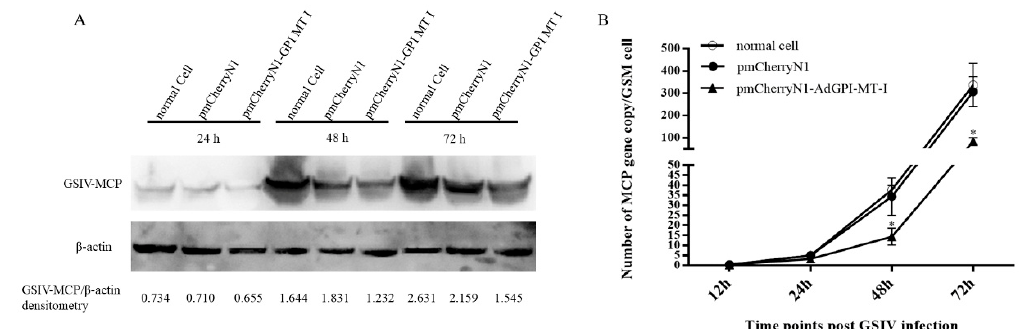
Figure 8. ( A ) Western blot analysis of MCP protein expression and grayscale quantitative analysis. Western blot was used to detect protein synthesis after GSIV infection at different times, and mouse anti-MCP monoclonal antibody and anti- β -actin monoclonal antibodies were used as primary an- tibodies, respectively. HRP-tagged antimouse IgG was used as a secondary antibody. β -actin was used as internal control. The gray values of GSIV-MCP and β -actin protein bands were quantitatively analyzed by ImageJ software. ( B ) Digital droplet PCR (ddPCR) was used to detect the MCP gene copy number of GSIV in GSM cells. After transfection of pmCherryN1-AdGPI-MT-I plasmid with GSM cells for 48 h, the copy number of the MCP gene at 0, 12, 24, 48, and 72 h after GSIV infection was detected by ddPCR. Error bars indicate the mean ± SD ( n = 3). The asterisks indicate significant difference (* p < 0.05) between treated and control groups.